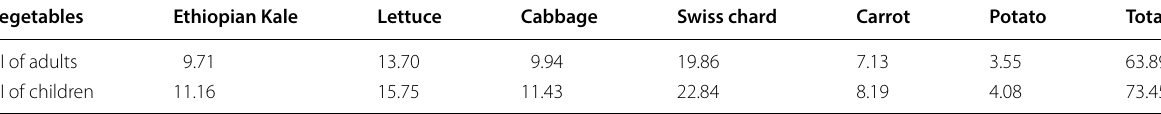
Table 7 Average hazard index (HI) in the vegetable samples Vegetables Ethiopian Kale Lettuce Cabbage Swiss chard Carrot Potato Total HI HI of adults HI of